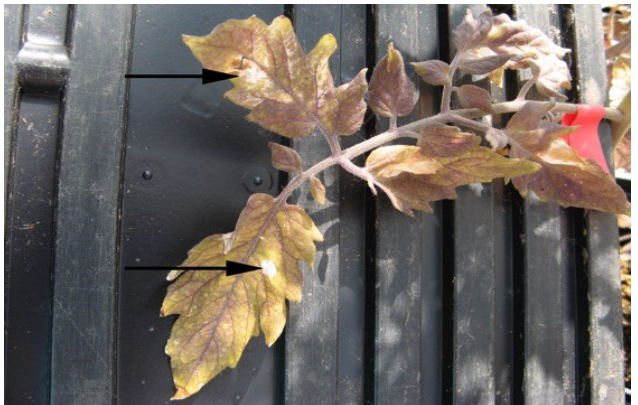
Figure 3. Tomato leaf from a plant that had been leaf inoculated with Salmonella Typhimurium-GFP. The arrow marks a necrotic lesion on the plant that resulted from the point of inoculation on the